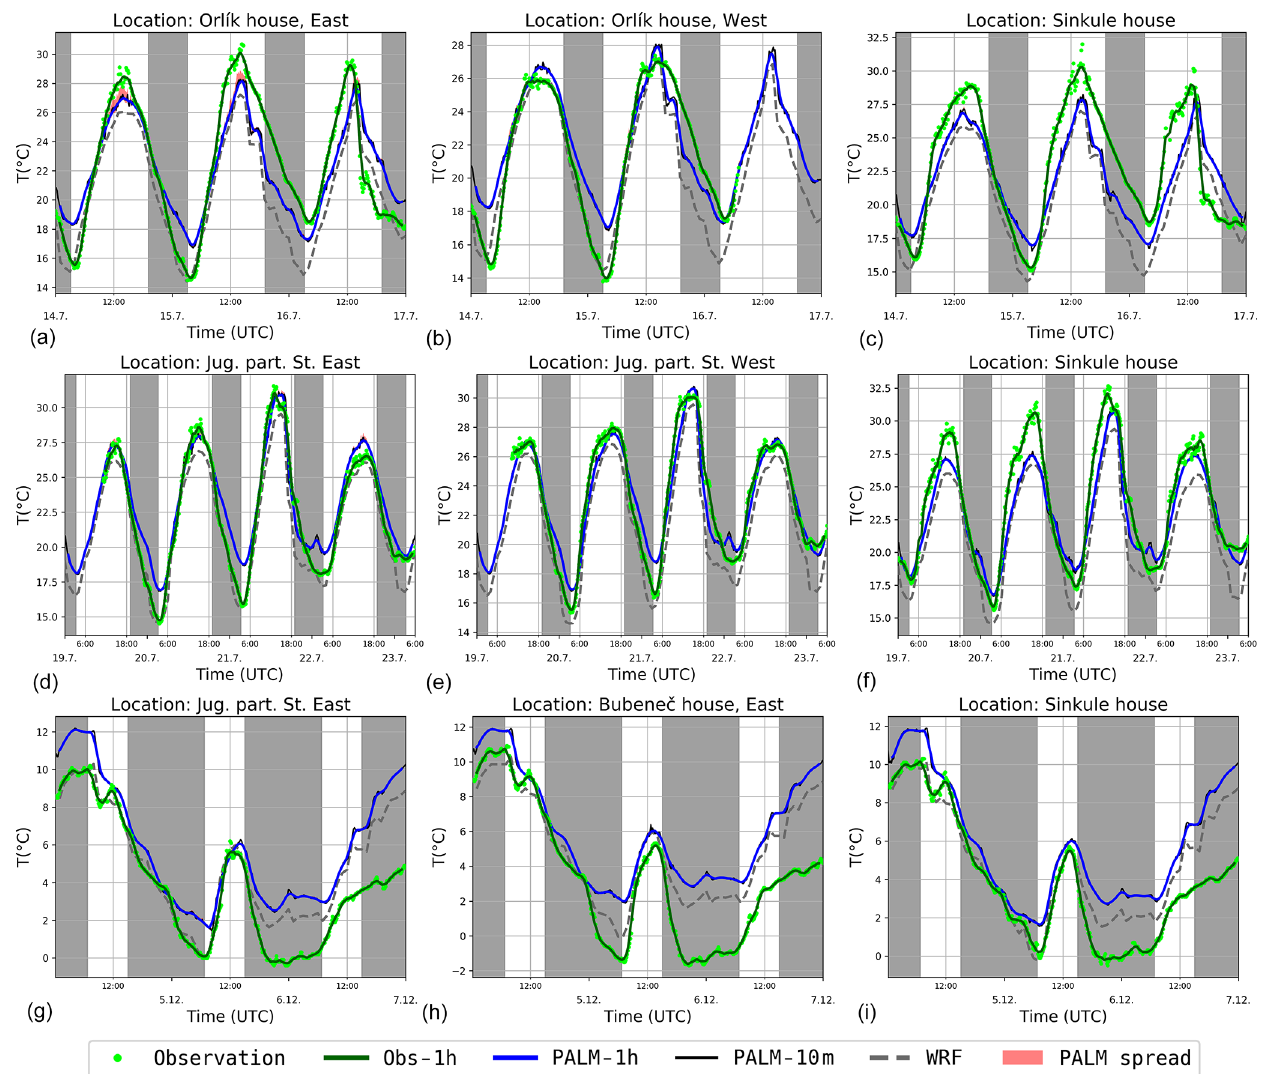
Figure 26. Street canyon temperature at 3.9m (Sinkule house) and 4.6m (other) for the summer e1 (a, b, c) , summer e2 (d, e, f) , and winter e3 (g, h, i) episodes. Observations are shown as 10min averages (green dots) and moving 1h averages (green line). PALM simulations are shown as moving 1h averages (blue line), 10min averages (solid black line), and the interval between the smallest and the largest 10min average among the neighbouring grid points (red band). The grey dashed line denotes the 1h averages of temperature at 2m at the closest WRF grid point. The grey shaded areas indicate night-time. Please note that the black curve indicating the 10min average is mostly hidden by the blue curve indicating the 1h average. The spatial variations in temperature are usually very small, especially in the winter case, meaning that the red curve is hidden most of the